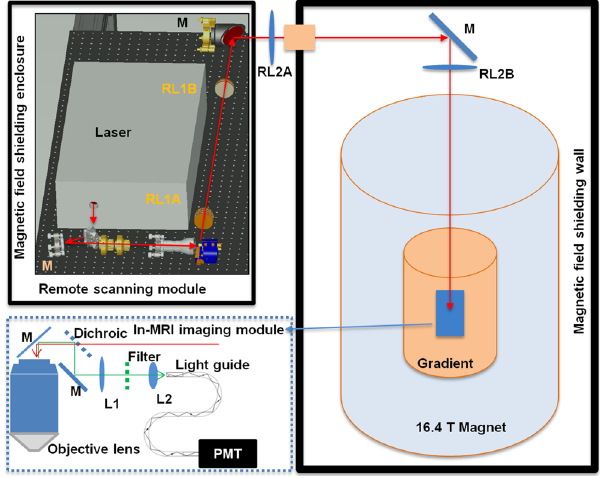
Figure 1. Schematic of the MRI-compatible TPM imaging system. The laser scanning module (upper left corner) was located outside the 16.4T magnet room and contained inside a magnetic field shielding enclosure. The excitation laser beam was guided to the in-MRI imaging module inside the magnet by two sets of relay lenses (RL1A, RL1B, RL2A and RL2B) and mirrors (M). The in-MRI imaging module (enclosed by the blue dotted box) comprised an objective lens, a dichroic beam splitter, an optical mirror, a filter and two lenses (L1 and L2) which focused the two-photon excited fluorescence emission onto the entrance port of a 9 meter long fiber light guide. The exit port of the light guide was in contact with the front window of a GaAsP PMT housed inside the enclosure of the remote scanning module.